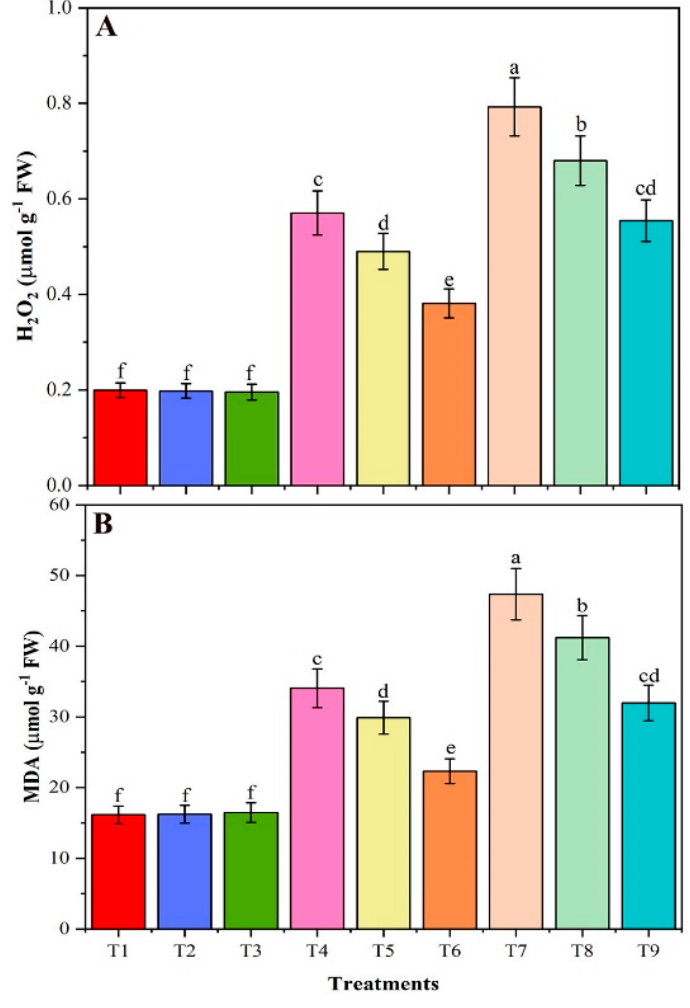
Figure 6. The hydrogen peroxide (H 2 O 2 ) content ( A ) and lipid peroxidation (MDA) level ( B ) from leaves of un-amended and amended soybean plants with chitosan modified and as-is biochar under saline conditions. Data are shown as the mean ± standard deviation (n = 3). Different letters above the chart columns indicate significant differences among treatments ( p ≤ 0.05).